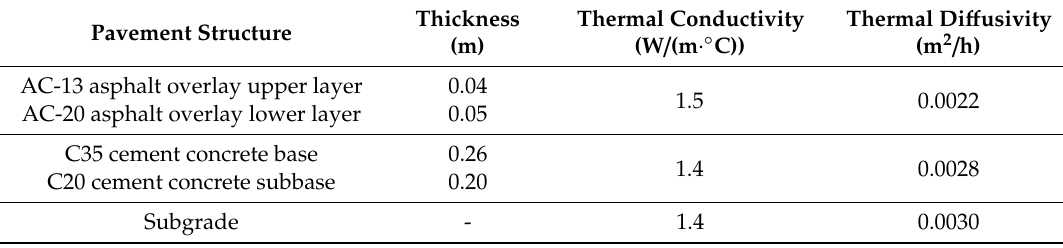
Table 3. The input parameters in the model verification.